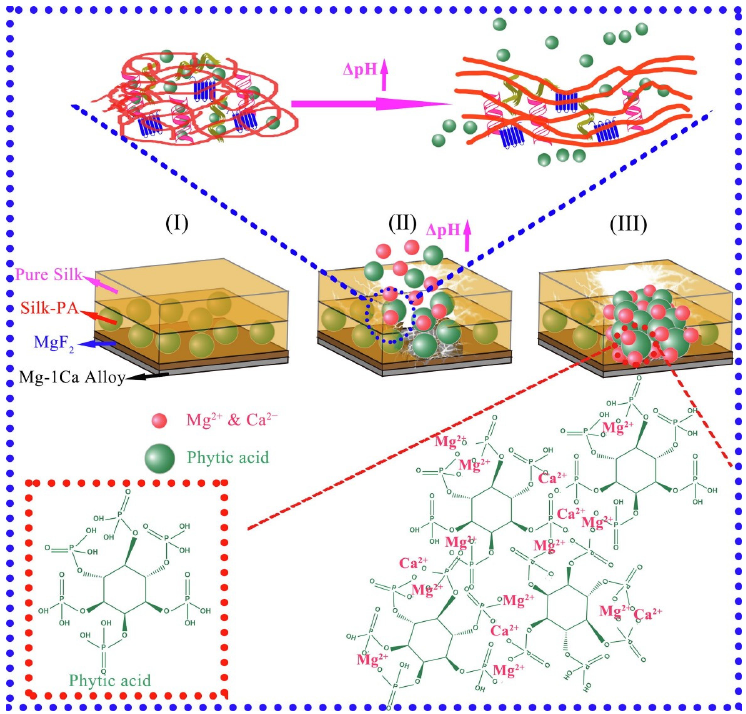
Figure 11. Schematic of the self-healing mechanism upon silk-PA exposure in the immersion environ- ment. Reprinted with permission from Ref. [94]. Copyright (2019)